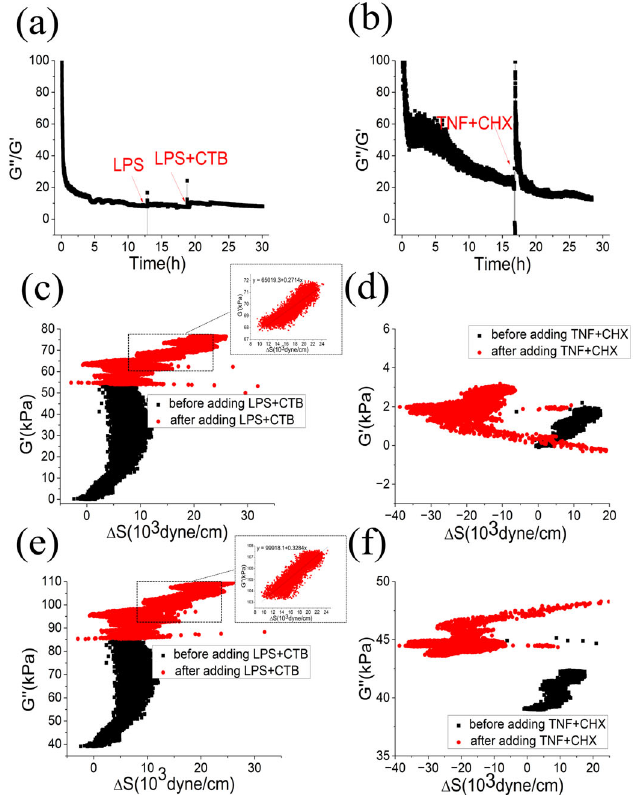
Figure 7. Changes in loss tangent and correlations between cytomechanical parameters during the LPS and CTB induced pyroptosis-resistance and TNF and CHX induced apoptosis in 2000 GSDMD − / − (-DEVD-) mutant expressing HeLa cells on FN modified quartz crystal-Au surfaces. ( a,b ) changes in loss tangent η = G (cid:48)(cid:48) / G (cid:48) ; ( c ) G (cid:48) versus ∆ S correlation during LPS+CTB stimulation; ( d ) G (cid:48) versus ∆ S correlation during TNF+CHX stimulation; ( e ) G (cid:48)(cid:48) versus ∆ S correlation during LPS+CTB stimulation; ( f ) G (cid:48)(cid:48) versus ∆ S correlation during TNF+CHX stimulation.